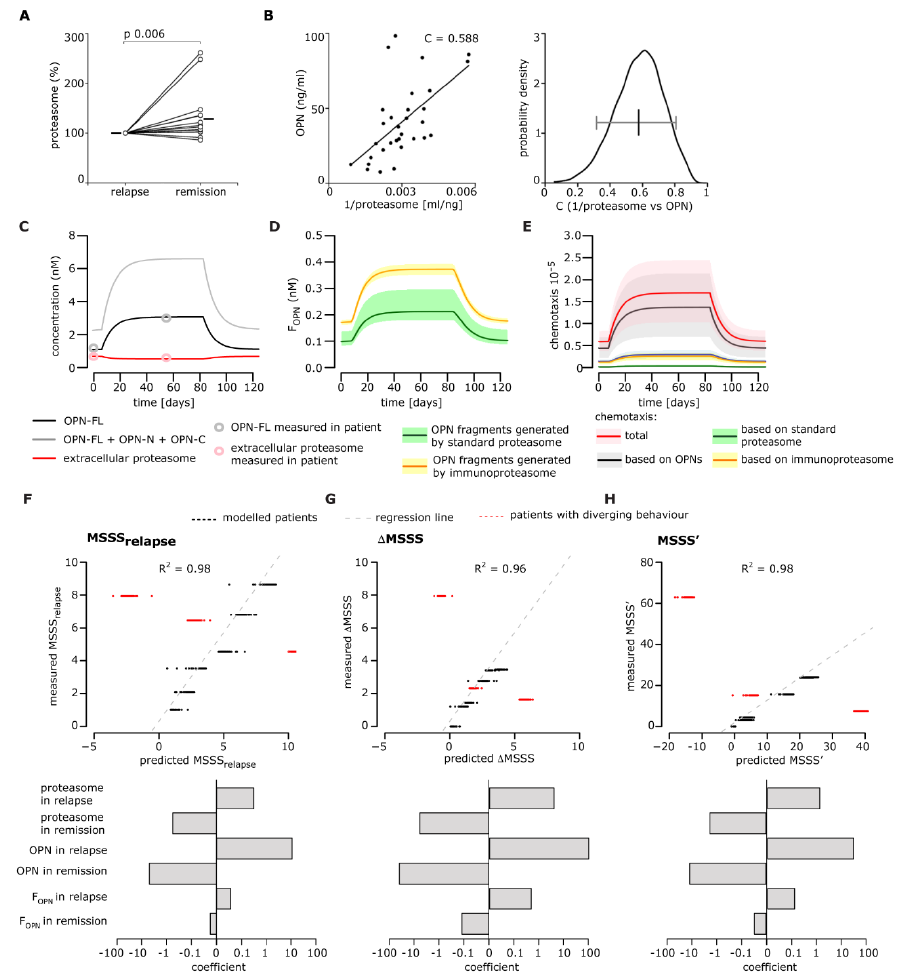
Figure 7. Correlation between relapse severity and serum OPN-proteasome dynamics in an RRMS